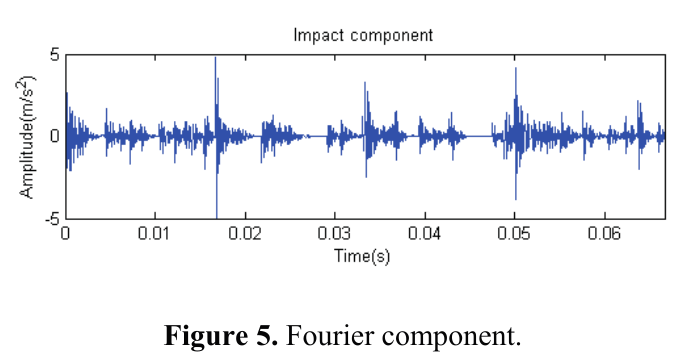
Figure 4. Impact component.